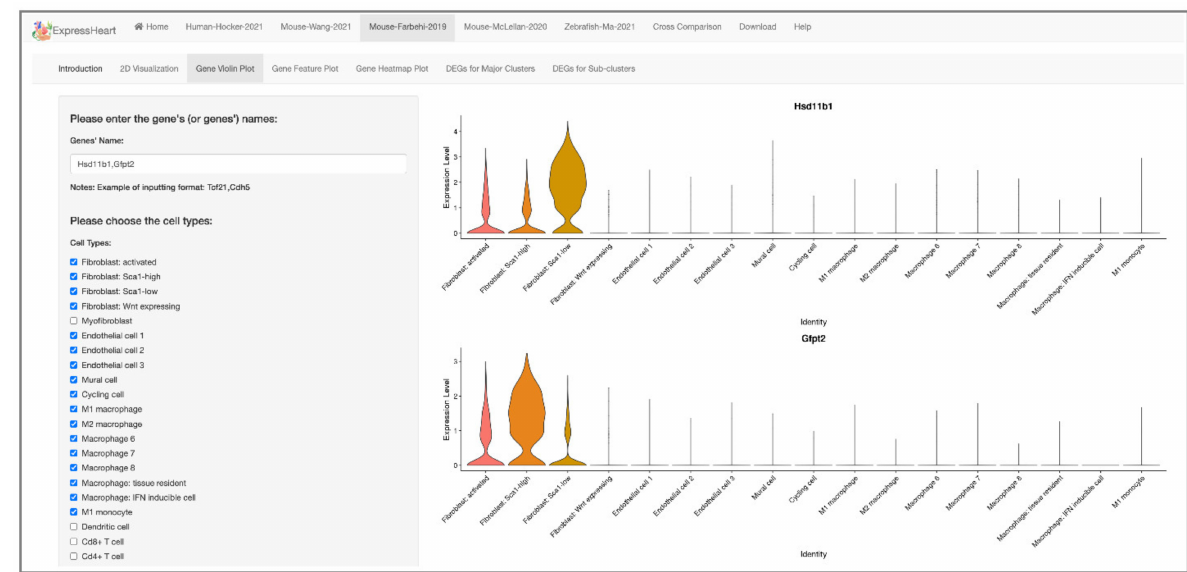
Figure 6. Comparison between two mice datasets. The two violin plots show the expression profiles of the feature genes of two fibroblast subtypes ( Hsd11b1 and Gfpt2 , respectively) in the Mouse-Wang-2021 dataset in the major subtypes identified in the Mouse-Farbehi-2019 dataset. Users can type in the name(s) of target gene(s) and choose the cell type(s) of interest by checking the corresponding box(es) on the left panel, and the violin plot(s) showing the gene expression level will be presented on the